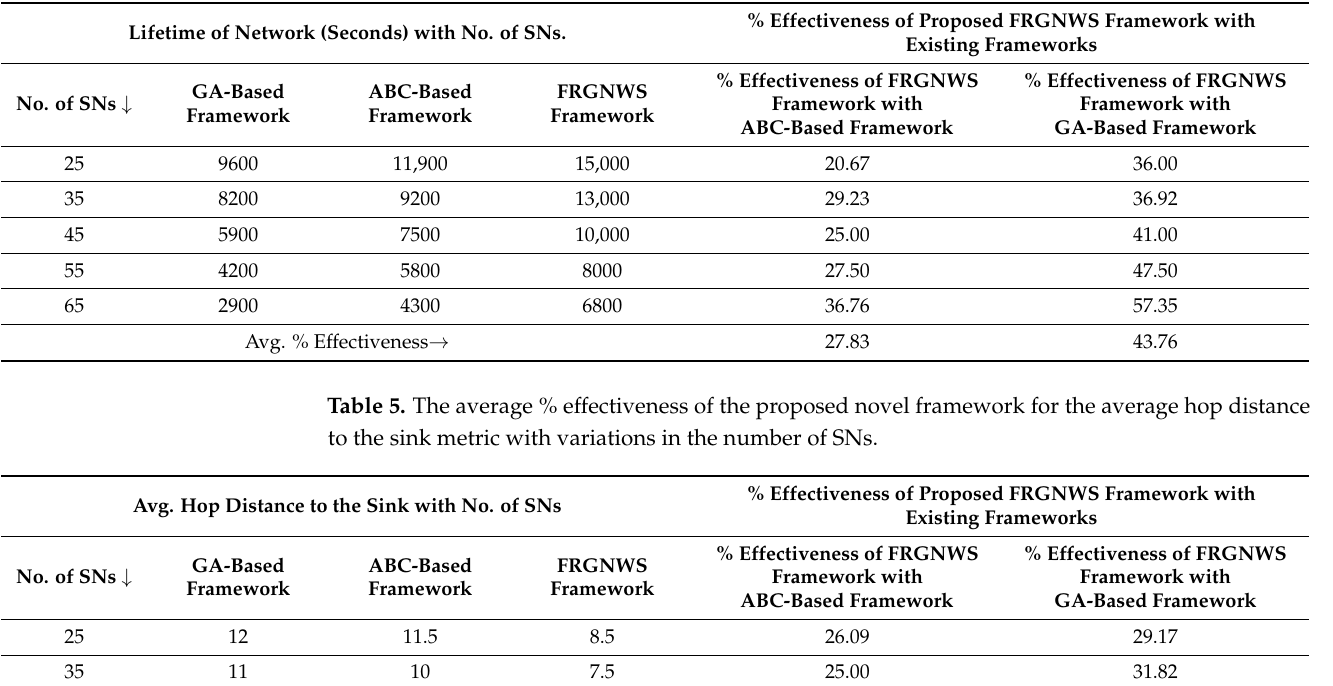
Table 4. The average % effectiveness of the proposed novel framework for the lifetime of the network metric with variations in the number of SNs.